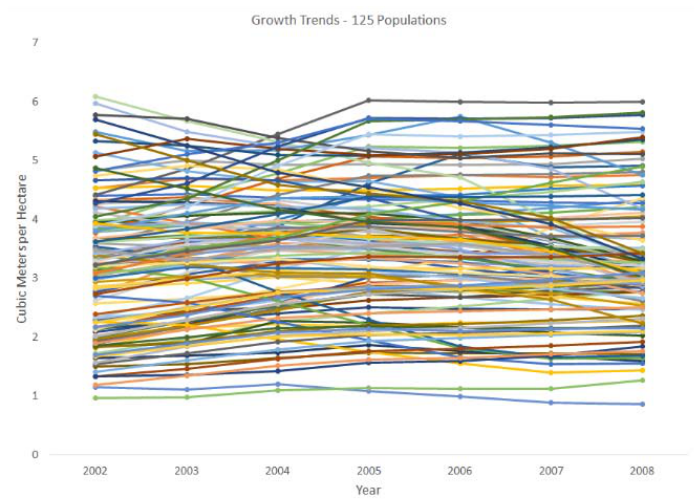
Figure 5. The mean trend in cubic meter growth per hectare per year for each of the 125 populations over the period of 2002 through 2008.